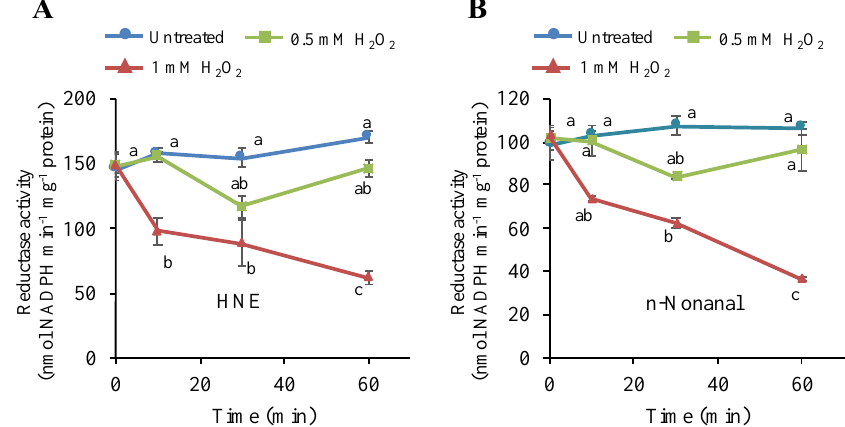
Figure 7. Effects of H 2 O 2 on the NADPH-dependent HNE-reducing and n -nonanal-reducing activities in tobacco BY-2 cells. Four-d cultured cells were treated with H 2 O 2 at 0.5 mM and 1 mM, as in Figure 1. Then, cells were harvested at the indicated time point, and proteins were extracted as in the Materials and Methods section. The reductase activities for ( A ) HNE and ( B ) n -nonanal were determined as in the Materials and Methods section. Each point represents the mean of three independent experiments and the error bars of the SEM. Different letters represent significantly different values ( p < 0.05 on Tukey test).